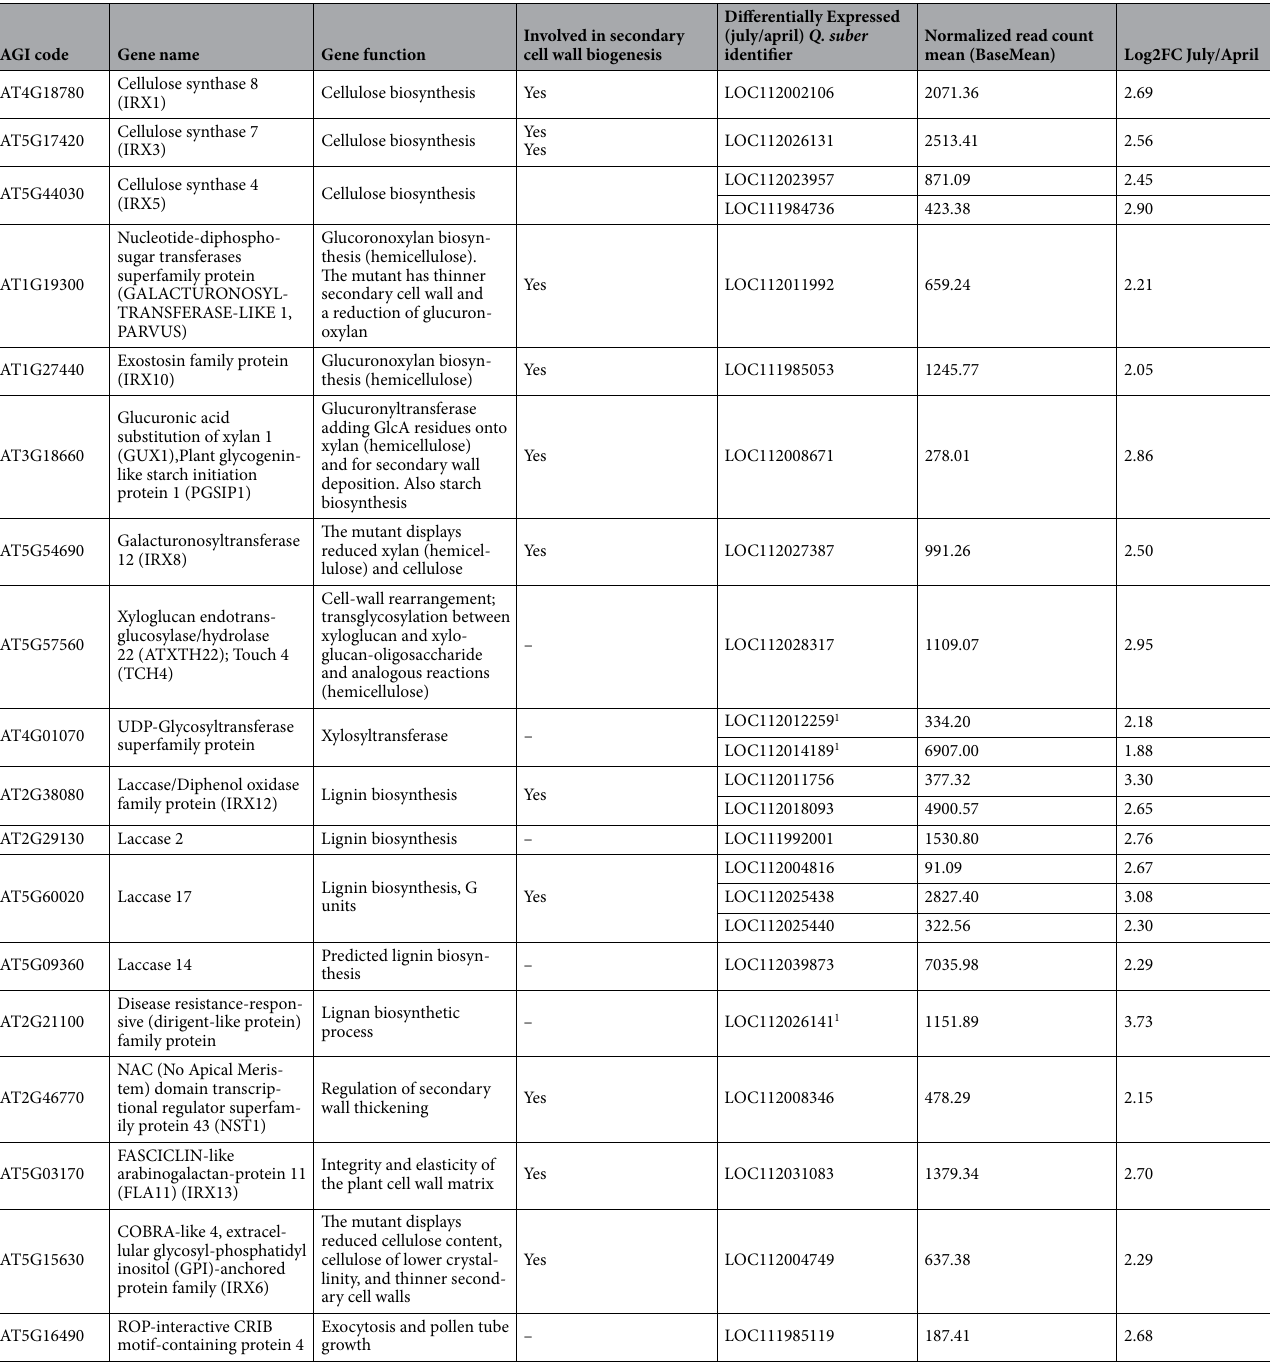
Table 2. Q. suber genes in cluster 1 (upregulated in July and/or June) classified within the enriched GOs related with cell wall biogenesis based on the most homologous Arabidopsis gene. 1 Also differentially expressed in June/April